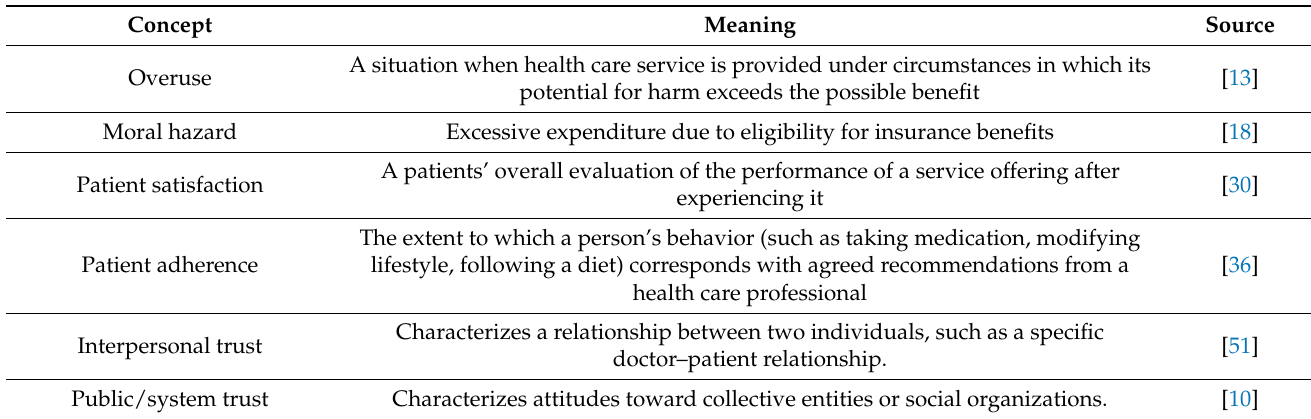
Table 1. The key concepts of the study.